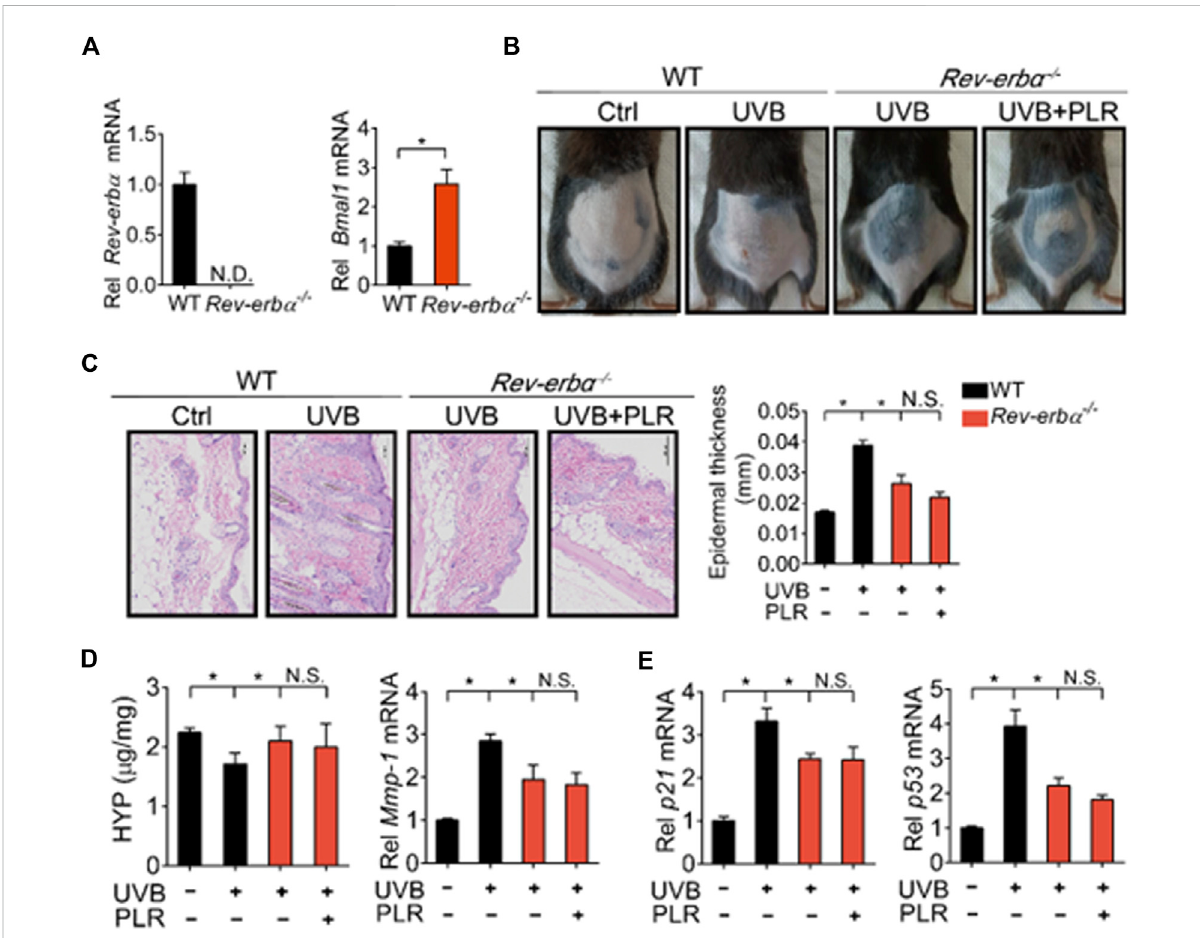
FIGURE 8 REV-ERB α is required for the protective effect of PLR on skin aging. (A) Knockout ef fi ciency of Rev-erb α . (B) Photographs of mouse skin in the different groups. (C) Representative images of H&E staining and quantitative analysis of the epidermal thickness. Scale bar: 100 µm. (D) HYP content and Mmp-1 mRNA level in mouse skin. (E) mRNA levels of p21 and p53 in the skin. 400 mg/kg PLR was used to treat the skin of mice. Data are presented as mean ± SD ( n = 4). * p < 0.05. WT, wide type; N.D, not detected; N.S, not signi fi